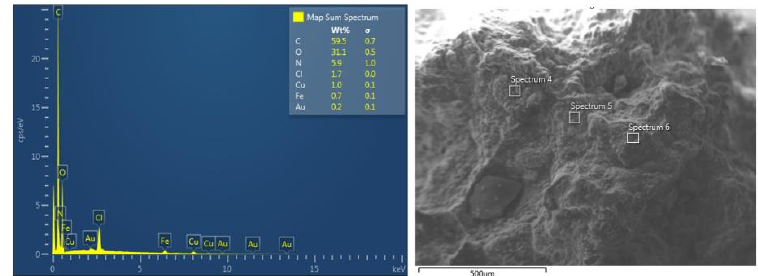
Figure 7. EDS spectrum of the NS–DTF complex.